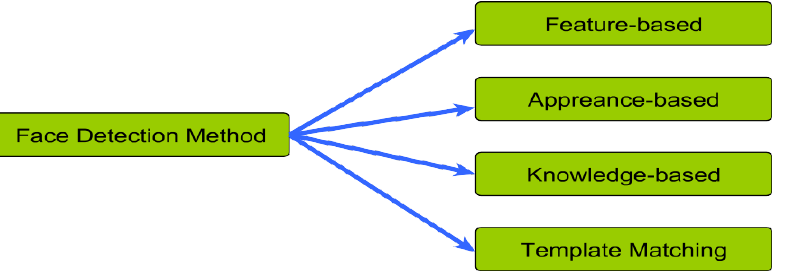
Figure 1. Different techniques for face